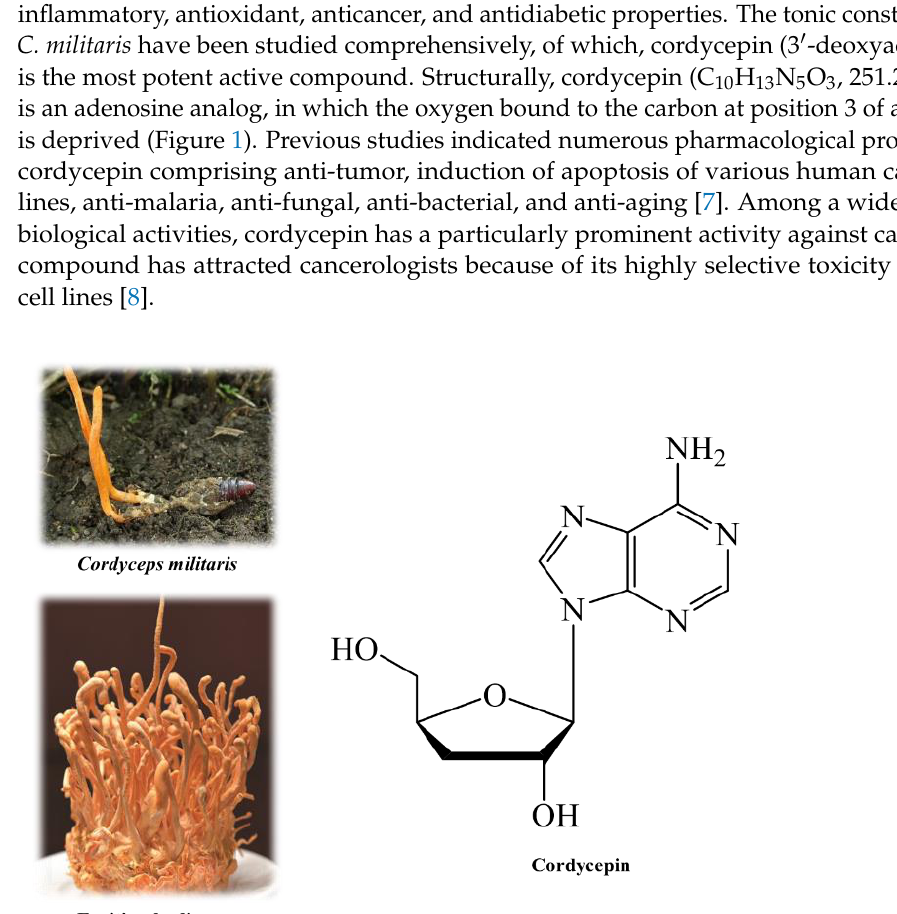
species as a raw material or